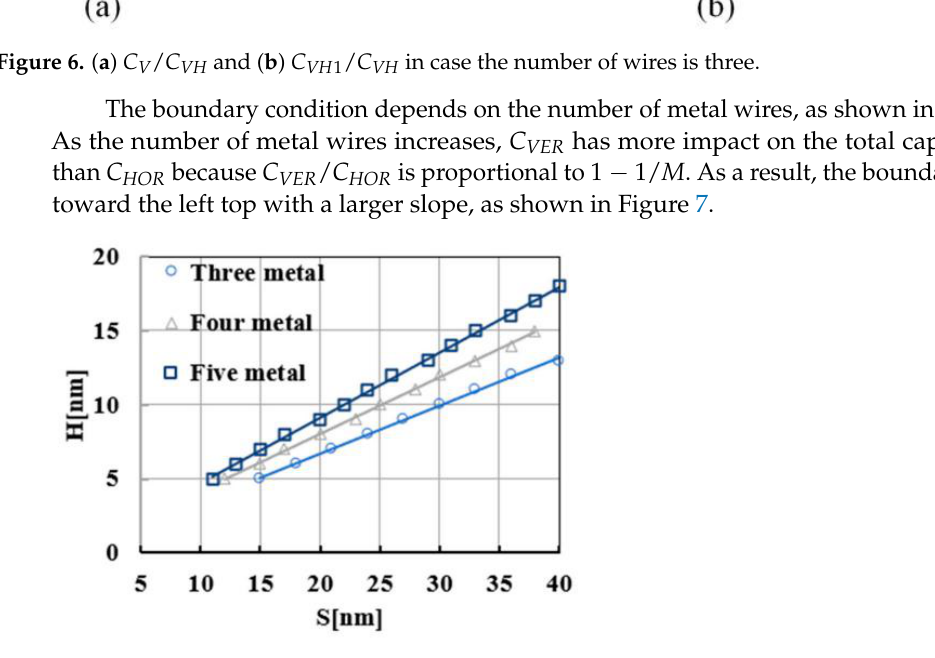
Figure 6. ( a ) C V / C VH and ( b ) C VH 1 / C VH in case the number of wires is three.